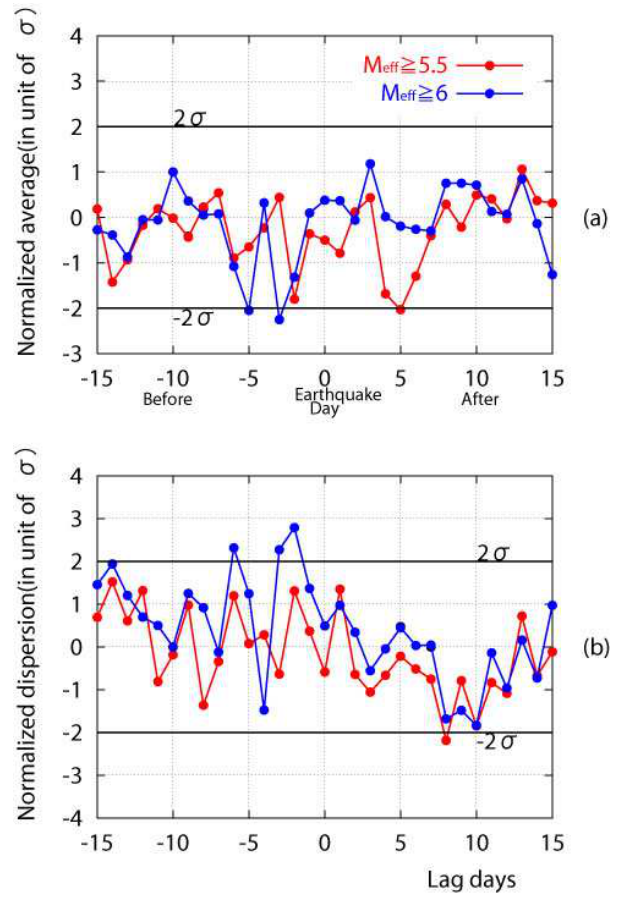
Figure 4. Statistical test result for the amplitude (a) and dispersion (b). The day on the abscissa is defined as follows: day zero indicates the day of the earthquake, and minus (plus) means that the phenomenon takes place before (after) the earthquake. The important 2 σ ( σ : standard deviation) lines are plotted for the statistical